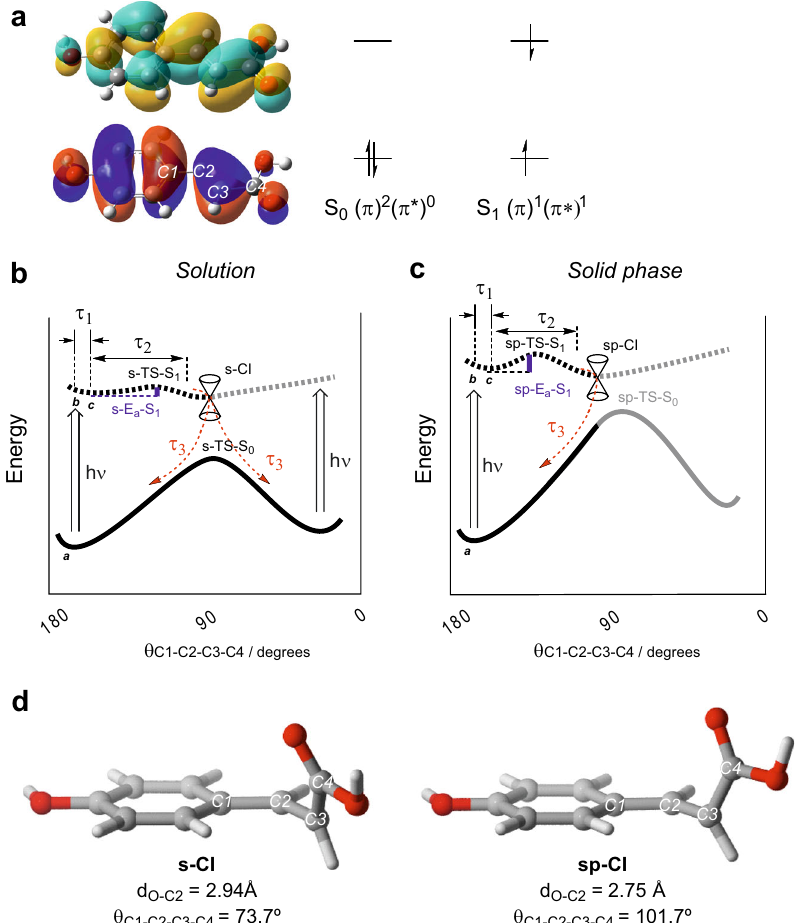
Fig. 4 Energy pro fi les for the trans - cis isomerization in ground and excited electronic states. a Frontier orbitals of p -coumaric acid and schematic representation of S 0 and S 1 electronic states computed at wb97XD/6-31 + G(d,p) level. b Solvated (s) model isomerization reaction pro fi le computed at wb97XD (PCM, methanol)/6-31 + G(d,p) level. c Solid phase (sp) model isomerization reaction pro fi le computed at wb97XD/6-31 + G(d,p) level. d Main geometrical features of conical intersections (CI) computed at CASSCF(12,11)/6-31 + G(d) (sp-CI) and CASSCF(12,11)/PCM,methanol/6-31 + G(d) (s-CI)